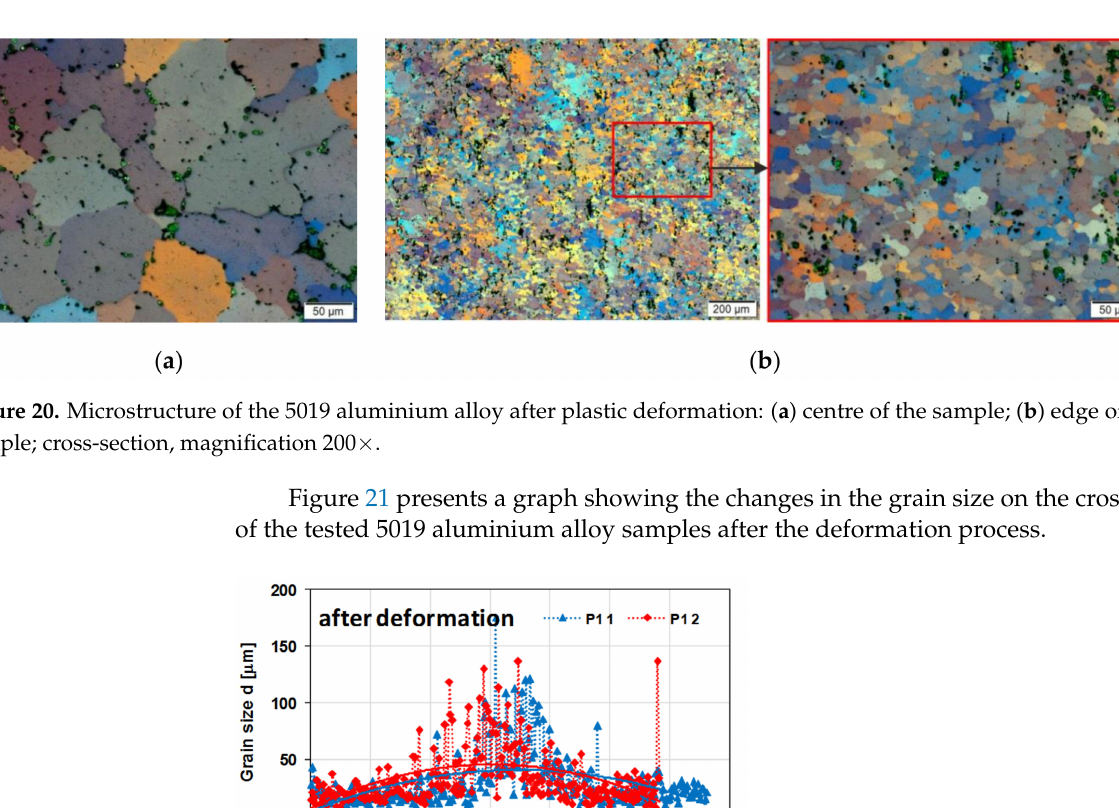
Figure 19. Microstructure of the 5019 aluminium alloy after plastic deformation: ( a ) cross-section; ( b ) longitudinal section.